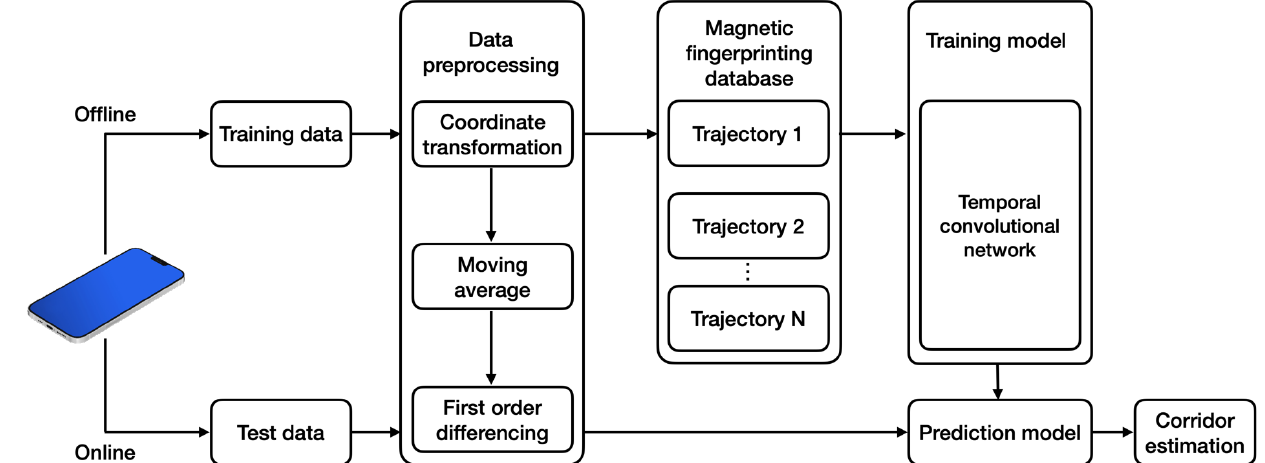
Figure 6. Scheme of the indoor magnetic trajectory classification based on a temporal convolutional